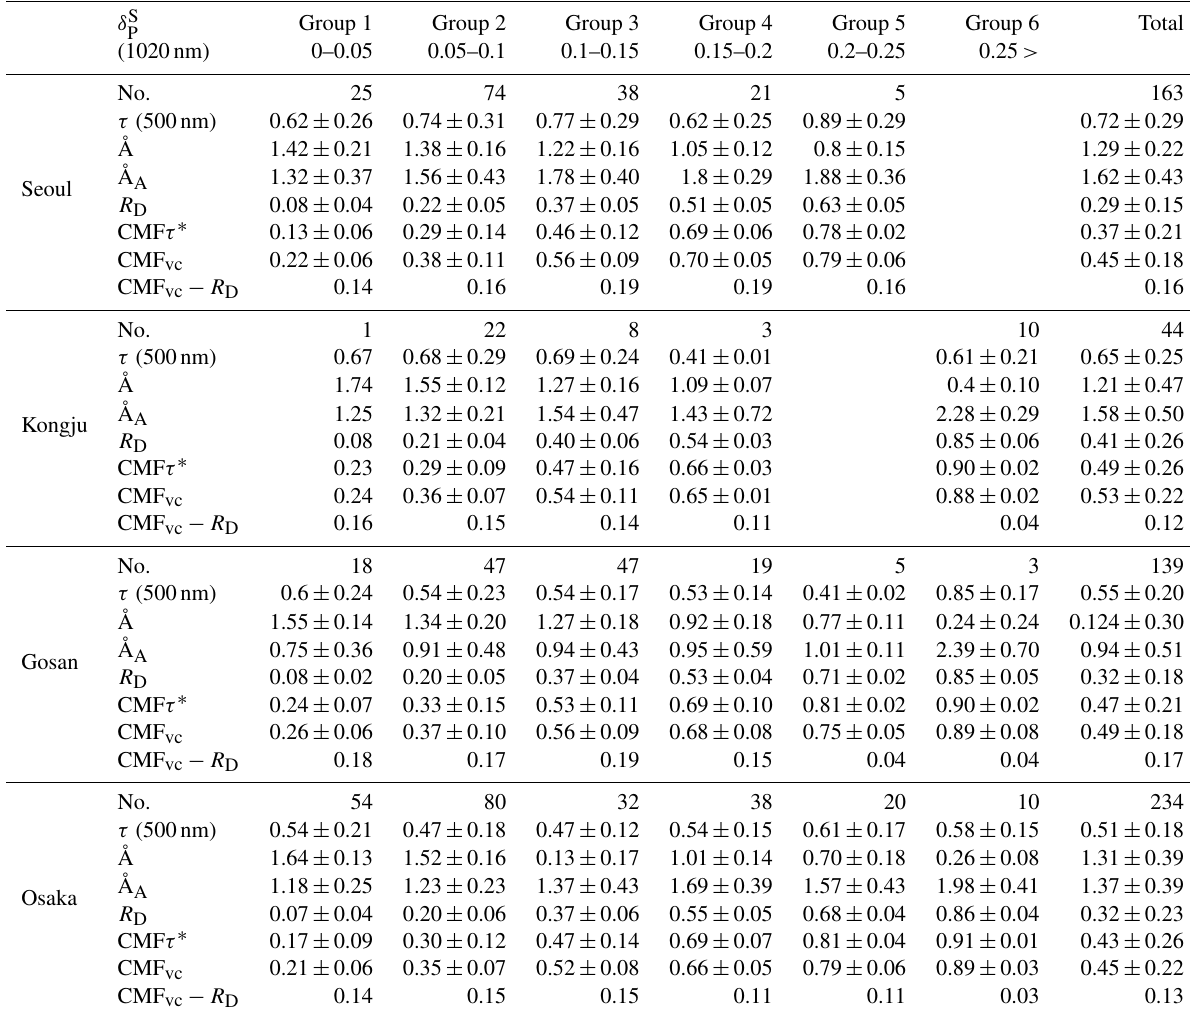
Table 1. Average value of aerosol optical depth ( τ ) at 500nm, optical-depth-related Ångström exponent (Å, 440–870nm), absorption-related Ångström exponent (Å A ), dust ratio ( R D ) derived by δ S at 1020nm, coarse-mode fraction of the τ at 1020nm (CMF τ ), coarse-mode fraction P of the volume concentration (CMF vc ), and difference between CMF vc and R D (CMF vc − R D